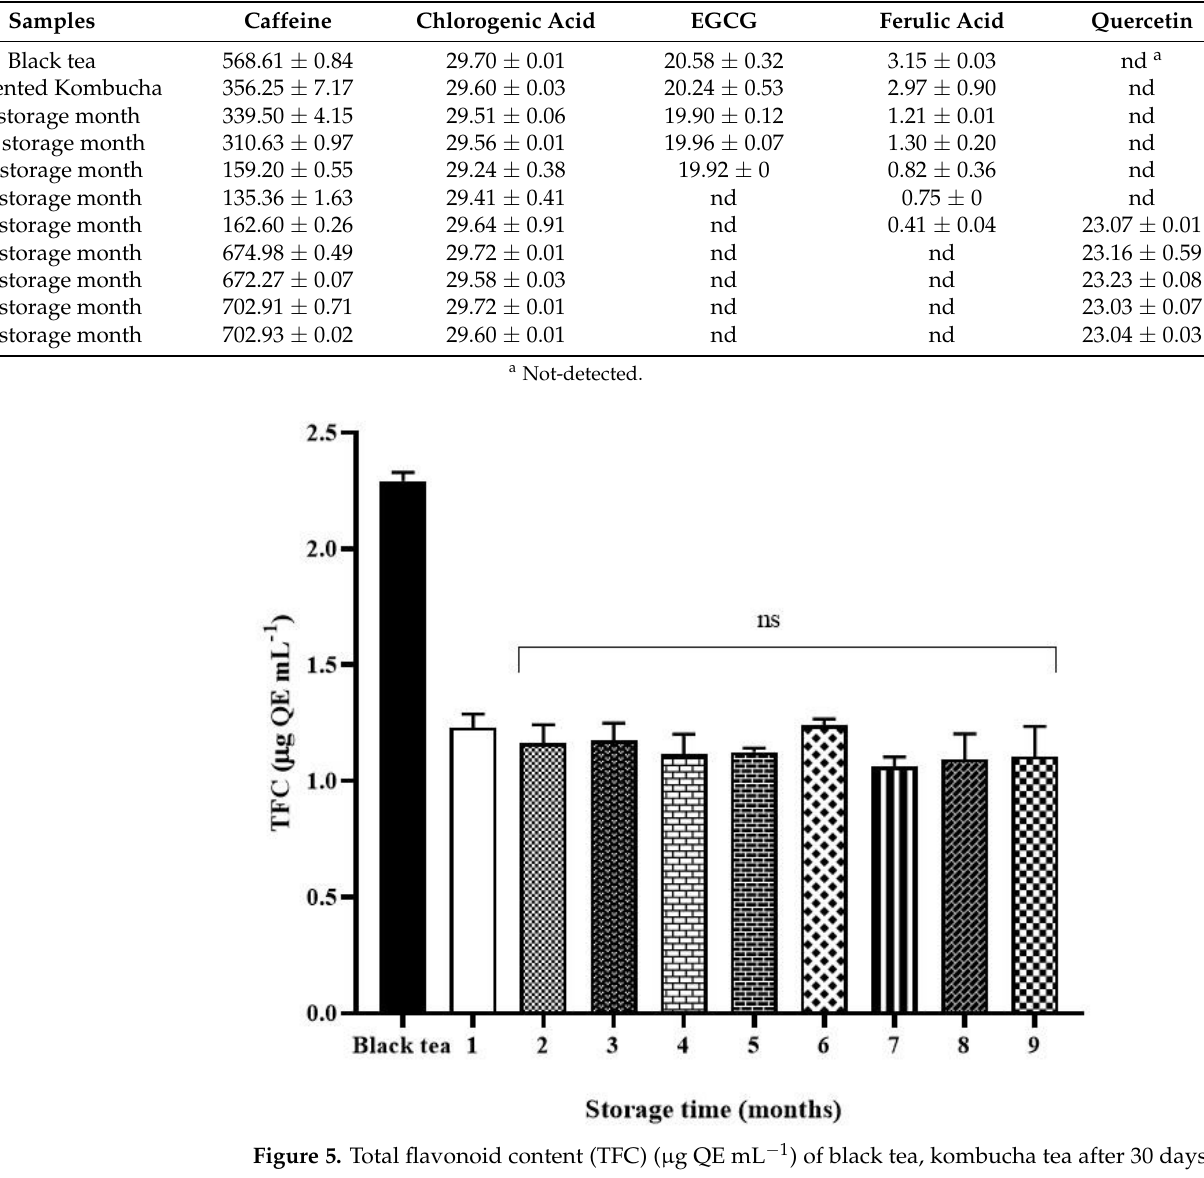
Table 1. Content of HPLC identified compounds, expressed as µ g mL − 1 .